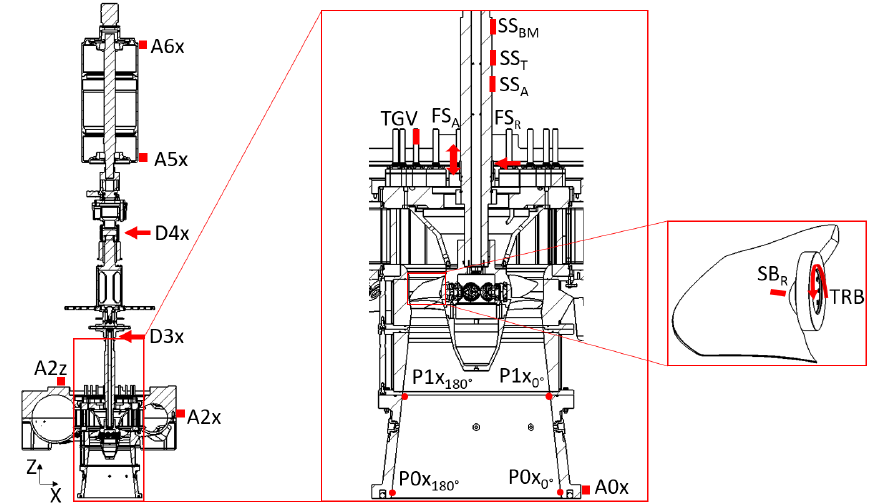
Figure 3. Positions of the sensors installed on the Kaplan turbine